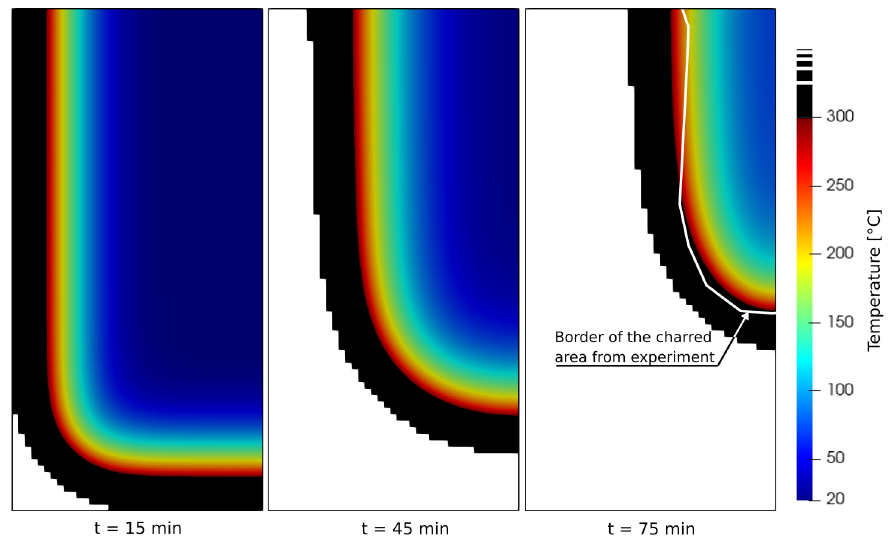
Figure 13. Beam exposure in 2D domain with temperature profiles. Black area = charred layer, white area = removed